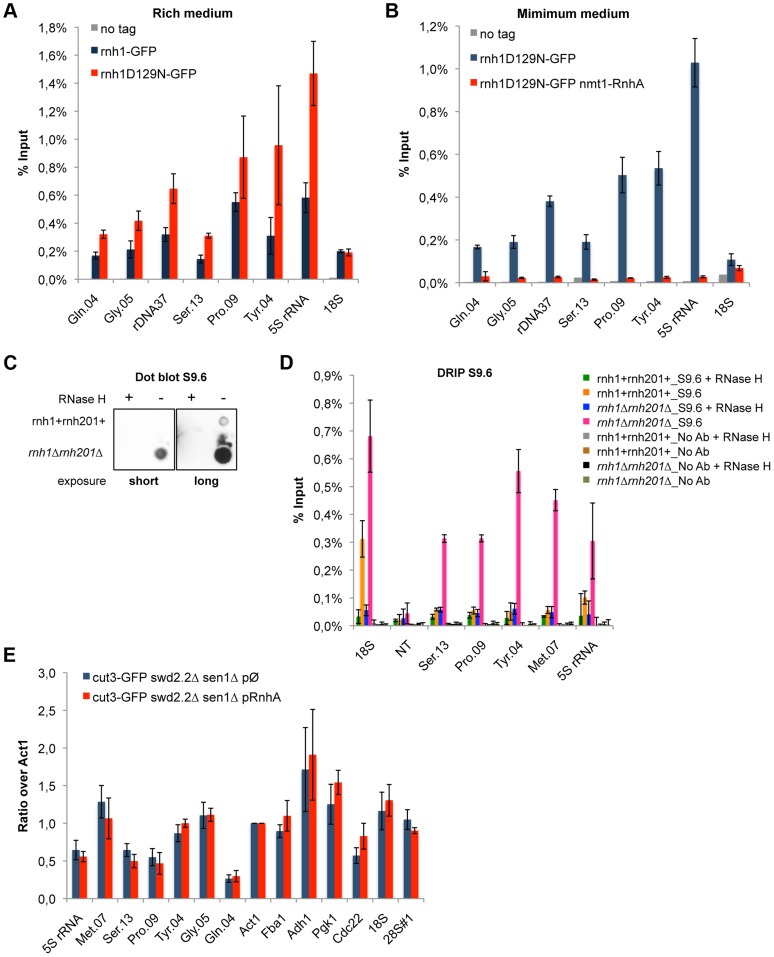
R-Loops form in abundance at Pol III-transcribed genes but they do not significantly impact the association of condensin.
A. ChIP qPCR of the indicated strains grown in cycling conditions at the indicated loci (mean ± standard deviation from 3 biological replicates). B. As in A. Cells were grown in minimal medium for a minimum of 18 hours to promote the over-expression of RnhA driven by the nmt promoter. C. Genomic DNA was extracted from rnh1+rnh201+ and rnh1Δrnh201Δ cells in preparation for the DRIP procedure. Equal amount of genomic DNA were spotted on a nylon membrane and incubated with 2 µg/mL of purified S9.6 antibody. The amount of S9.6 bound to the DNA was revealed using chemiluminescence. D. DRIP-qPCR of the indicated strains grown in cycling conditions at the indicated loci (mean ± standard deviation from 3 biological replicates). E. Cells of the indicated genotypes were grown in minimum medium lacking thiamine for a minimum of 18 hours to drive the over-expression of RnhA. ChIP-qPCR was then performed (mean ± standard deviation from 3 biological replicates).